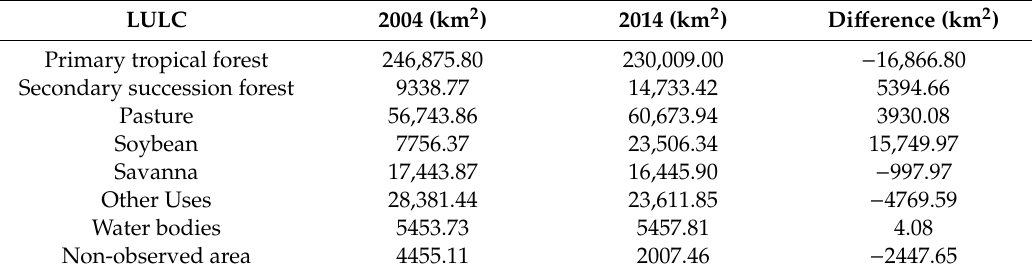
Table 1. Area of the land-use and land-cover (LULC) classes in the Xingu River Basin for 2004, 2014, and the di ff erence between these